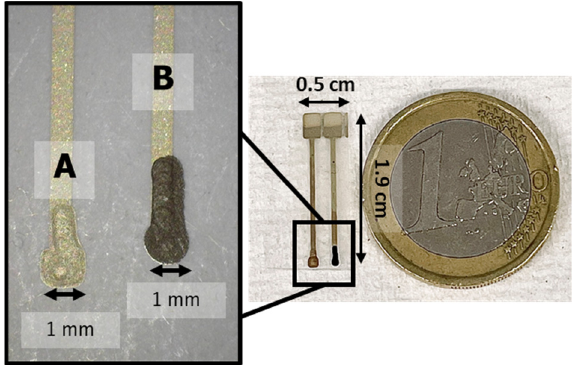
Figure 1. Photograph of the full size of the platform compared with EUR 1 coin and close-up of ( A ) Ag/AgCl electrode and ( B ) Gr electrode.